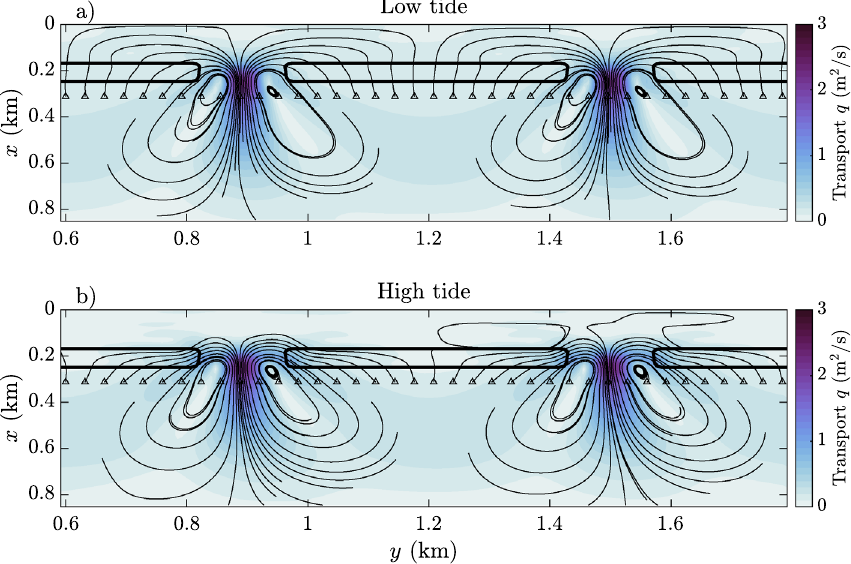
Figure 3. Streamlines of Lagrangian transport on ( a ) low tide and ( b ) high tide for the C D = 0.001